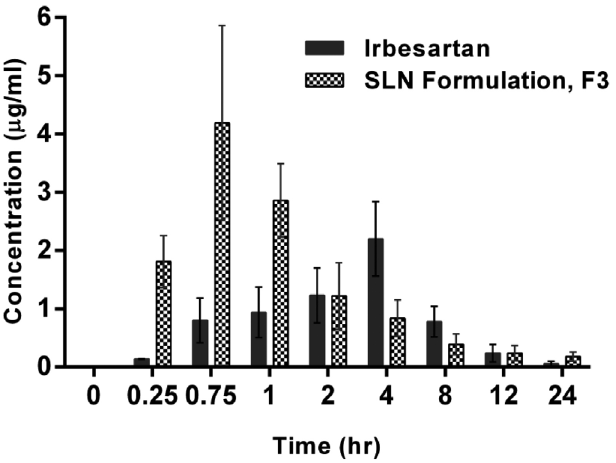
FIGURE 5 - Plasma concentration profile of irbesartan and irbesartan-loaded SLN